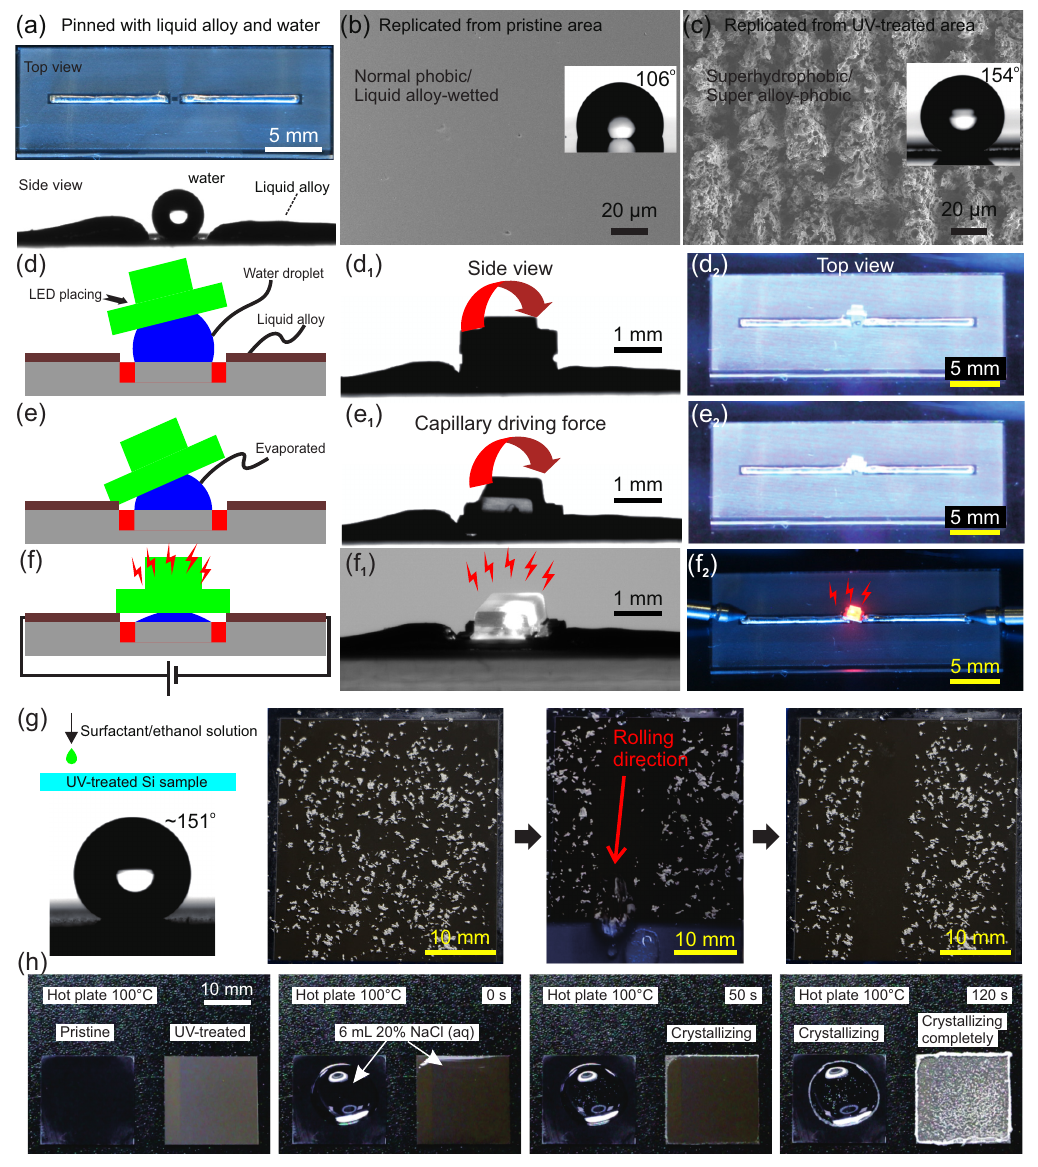
Figure 5. Demonstrations of Si with self-similar hierarchical micro–nano structures. ( a – f ) LED self-assembly with a replicated PDMS substrate from the treated Si master. ( a ) Top view and side view of the replicated PDMS substrate with a hydrophobic/liquid alloy wetted and superhydrophobic/super liquid alloy-phobic areas, which were pinned with liquid alloy lines and water droplets (side view). ( b , c ) FSEM views of areas replicated from pristine Si ( b ) and UV-treated Si ( c ). Insets show a static contact angle of a 2 µ L water droplet on these two surfaces. ( d – f ) Schematic process of LED self-assembly via a capillary driving force along the evaporated water droplet. ( d 1 – f 1 ) Side view of self-assembling process. ( d 2 – f 2 ) Top view of the self-assembling process. ( g ) A self-cleaning demonstration via a slightly tiled (5 ◦ ) and perfluorooctyl trichlorosilane-treated Si sample. The dotted white points are chalk dust. ( h ) A heated salt crystallization demonstration on the Si surface with self-similar structures and a pristine one.